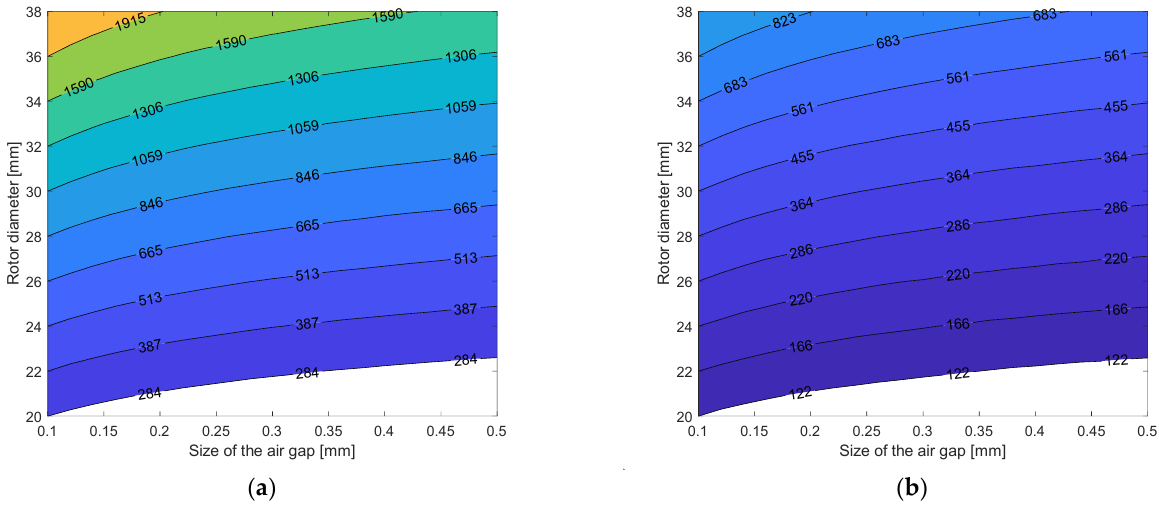
Figure 5. Results of the windage losses analysis: ( a ) salient poles; ( b ) smooth cylindrical